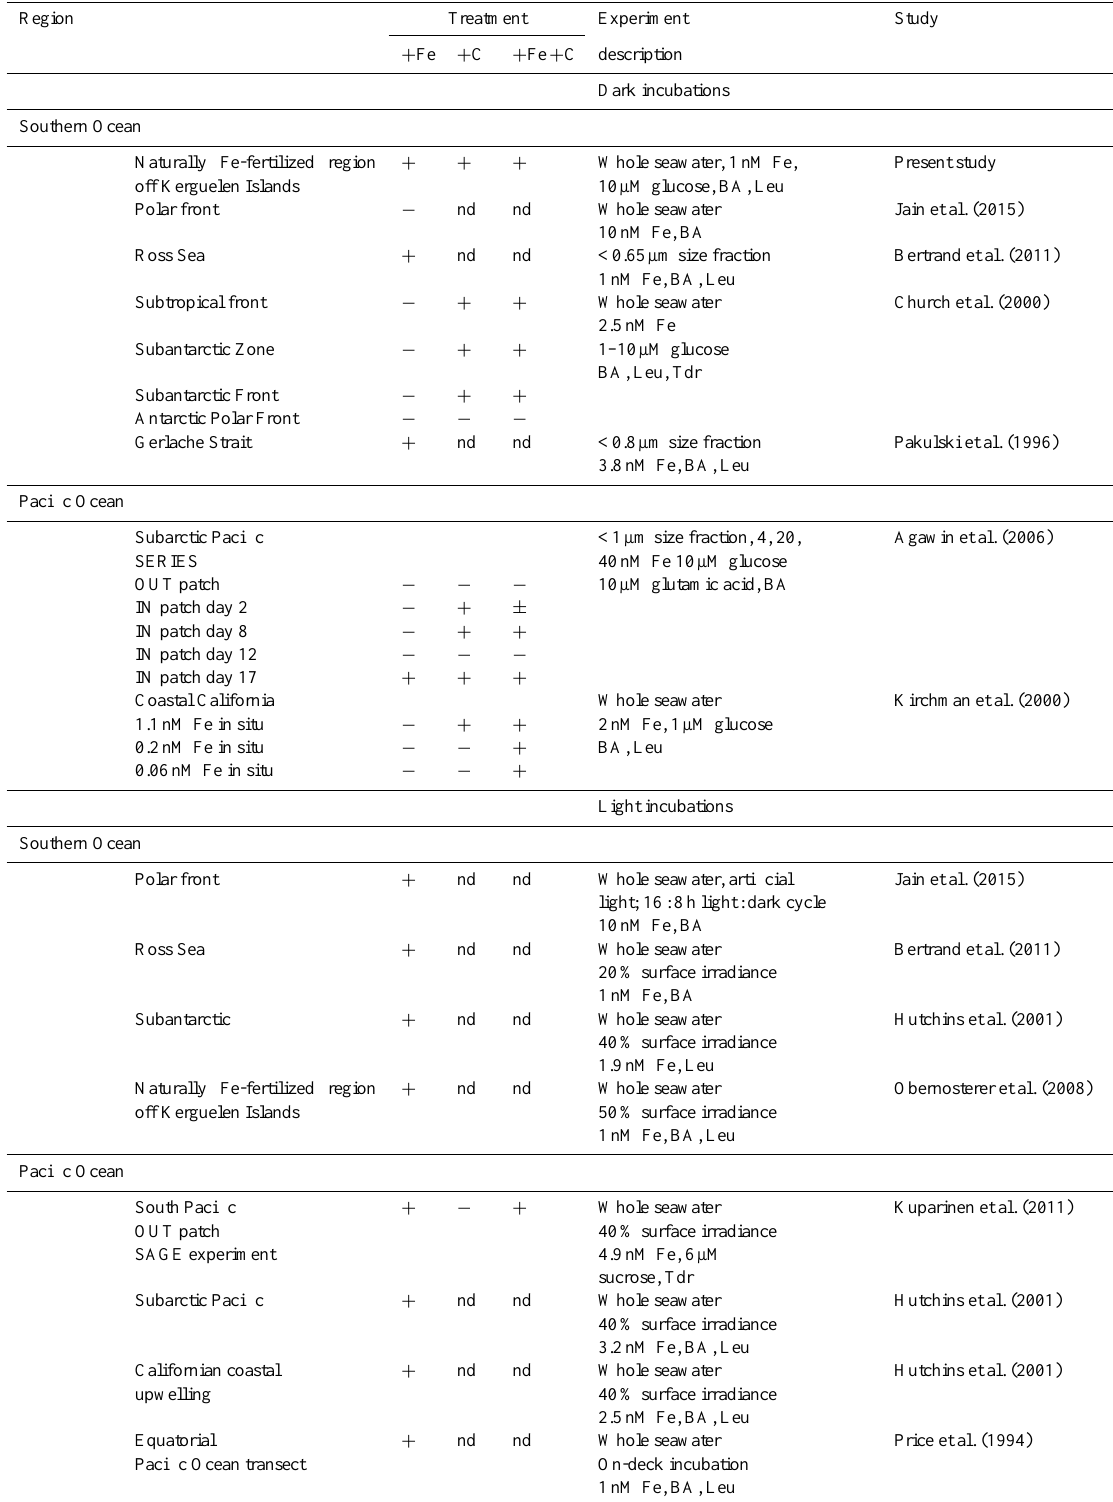
A positive or negative response of heterotrophic bacteria is indicated by “ + ” and “ − ” symbols, respectively; nd – not determined; final concentrations of added Fe and organic carbon source in the incubation experiments are given; Fe was added as FeCl 3 ; BA refers to bacterial abundance; Leu and Tdr refer to 3 [H] leucine and 3 [H] thymidine as tracers for bacterial heterotrophic production,